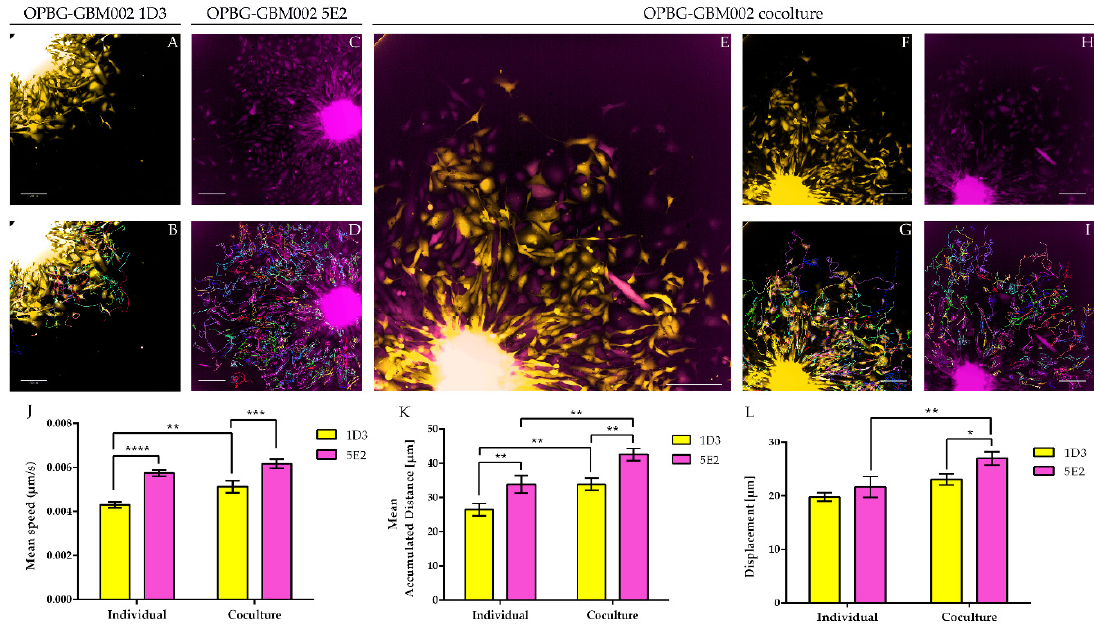
Figure 8. Single cell ‐ tracking—3D migration assay. Representative fluorescent images of OPBG ‐ GBM002 single cell ‐ derived clones 1D3 (( A ), m ‐ Orange) and 5E2 (( C ), Venus) 3D migration assays are shown as mono ‐ culture and as co ‐ culture 1:1 (( E ), overlay of m ‐ orange and Venus; ( F ), m ‐ Orange and ( H ), Venus). Images were acquired on the Operetta CLS (PerkinElmer) every 30 min for 96 time points and shown are the images relative to time point 40. Scale Bar = 200 μ m. Single cell ‐ tracking was performed using the Harmony software (PerkinElmer) and is represented with the lines and arrows overlayed on the fluorescent images (( B ) and ( D ) for 1D3 and 5E2 in mono ‐ culture, respectively; ( G ) and ( I ) for 1D3 and 5E2 in co ‐ culture, respectively). Mean speed ( J ), mean accumulated distance ( K ) and displacement ( L ) were analyzed with Harmony software. Data are mean ± SD, n = 3. (****) p < 0.0001; (***) p < 0.001; (**) p < 0.01; (*) p < 0.05.